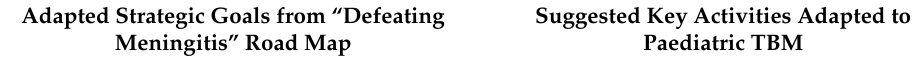
Table 4. Selected relevant strategic goals reproduced from Pillar 3 the “defeating meningitis” roadmap and suggested paediatric TBM-related activities [4]. Adapted Strategic Goals from “Defeating Suggested Key Activities Adapted to Meningitis” Road Map Paediatric